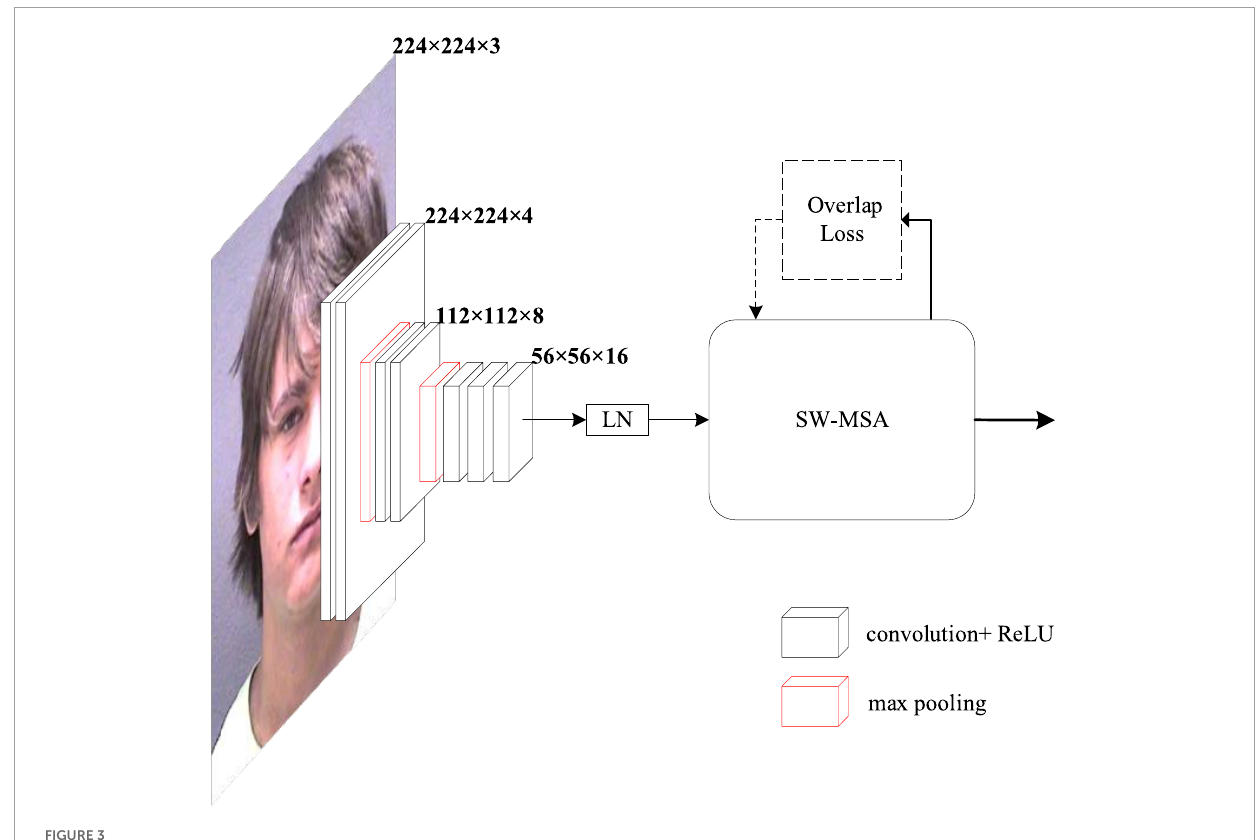
FIGURE3 Structure of the proposed attention-based convolution